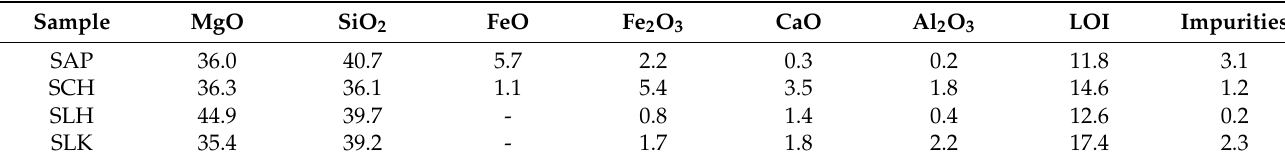
Table 1. Composition of serpentine samples by XRF